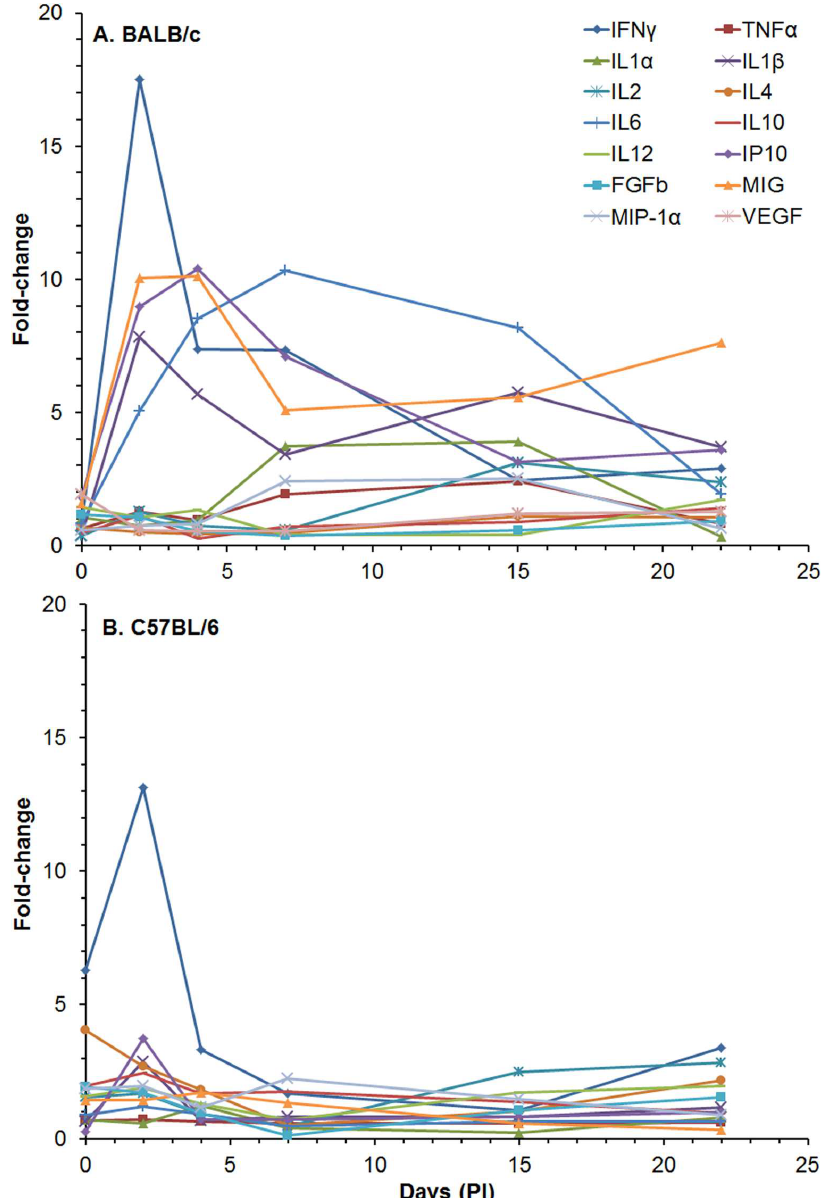
Fig 13. Changes in the amount of cytokines/chemokines in sera from BALB/c and C57BL/6 mice after aerosol exposure to B . pseudomallei K96243. The amount of cytokines/chemokines present in sera (S7 Table) was determined. For changesin cytokine/chemokinelevels in sera from BALB/c mice (A) , we show changesin levels up to 22 days post exposurebecausethere were no survivors after that period. We also show changesin cytokine/chemokinelevels in sera for C57BL/6mice (B) up to 22 days for comparisonand not many significantchangesoccurredafter 22 days in sera from C57BL/6mice. For each mouse strain N = 5 at each time point. Fold-changesin cytokines/chemokineswere determinedby dividingthe amount (pg/ml) present in sera of exposedmice (S7 Table)by the mount present in normal, na ï vemice, where N = 10 for BALB/c and N = 4 for C57BL/6mice. For C57BL/6 mice fold-change for MIG was not shown becauseit was very high (235-fold), and it would make obscurethe changesin the levels of the other cytokines/chemokines at the same